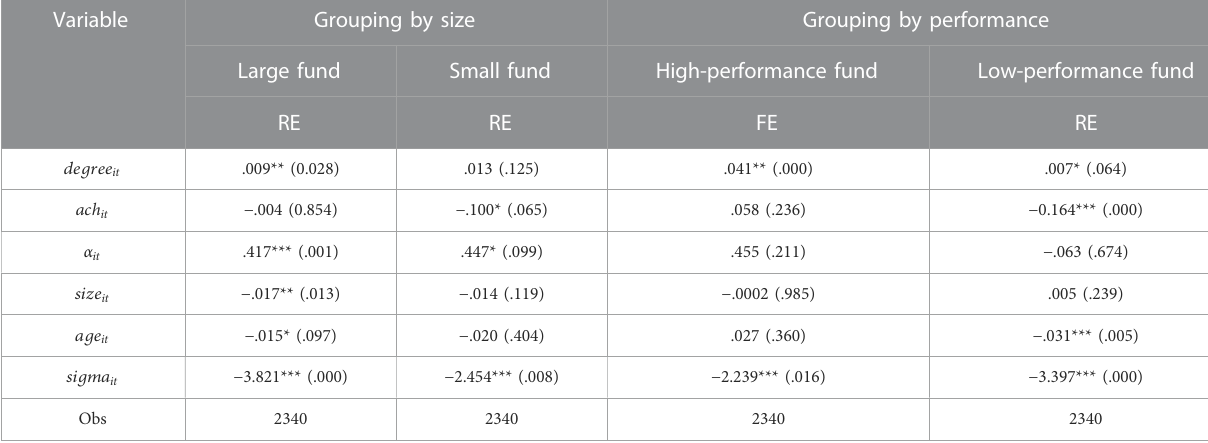
TABLE 5 Regression results of model (3) in different fund groups. Variable Grouping by